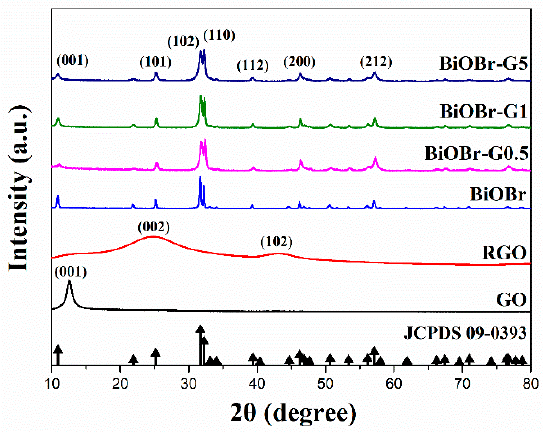
Figure 2. The XRD spectra of GO, RGO, BiOBr, and BiOBr-G samples (Black arrow show a standard card JCPDS 09-0393 of pure BiOBr) .